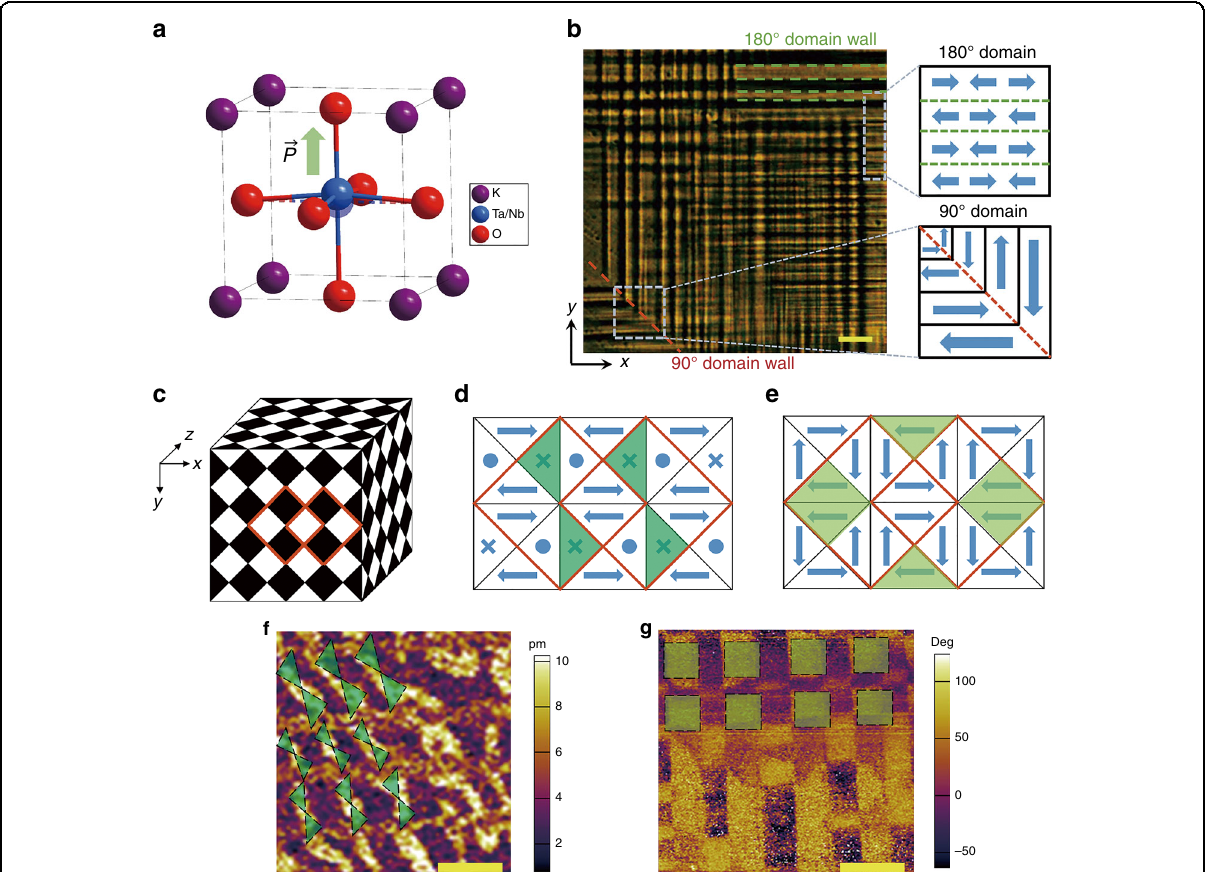
Fig. 1 Crystal structure and ferroelectric domain distribution of KTN. a Crystal structure of tetragonal KTN. b Polarizing microscope image of the KTN crystal along the x – y plane; the scale bar is 25 μ m. The red dotted line represents the 90° domain wall, and the green dotted line represents the 180° domain wall. The blue arrows represent the spontaneous polarization direction. c Diagram of natural Rubik ’ s cube-like domain structures in the KTN crystal. d Structural model of the ferroelectric domain (out-of-plane) in the KTN x – y plane. The solid forks and points represent inside and outside polarization. e Structural model of the ferroelectric domain (in-plane) in the KTN x – y plane. f Vertical PFM amplitude and g lateral PFM phase images of the KTN x – y plane in the same region. The scale bar is 2 μ